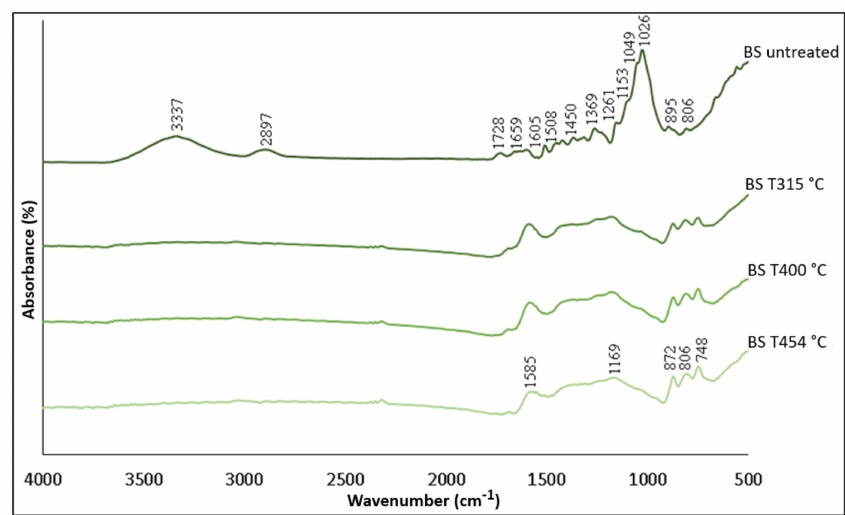
Figure 5. FTIR spectra of black spruce pellets at different heat